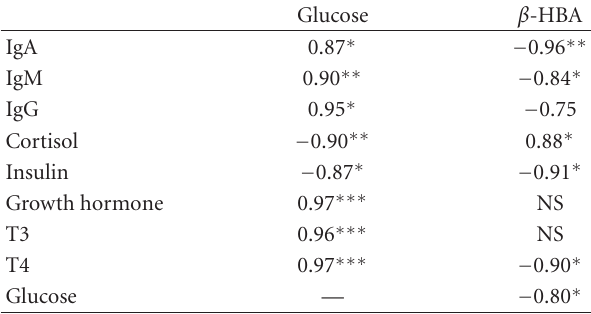
Table 1: The correlations of glucose and β -HBA concentrations with immunoglobulins, cortisol, insulin, growth hormone, and thyroid hormones in pregnancy toxemic goats.